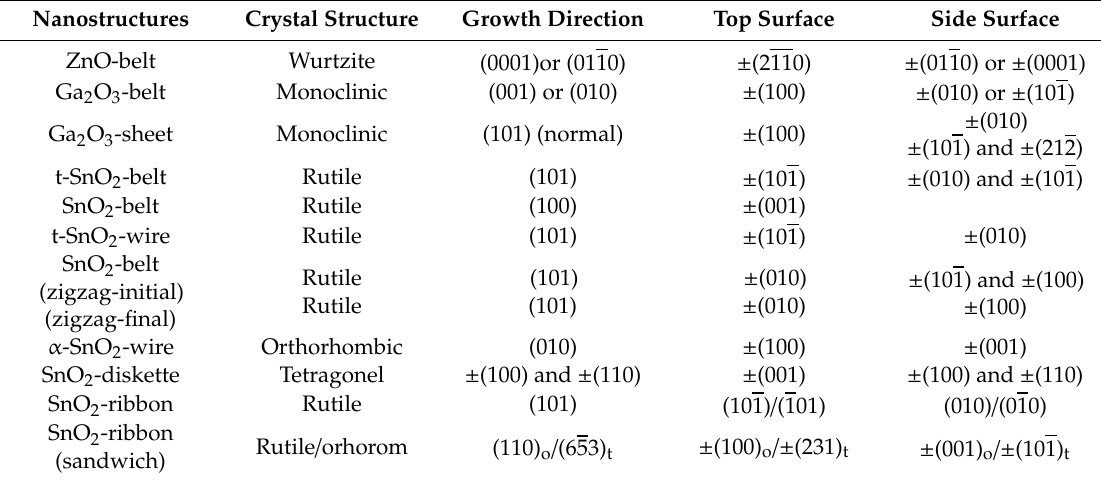
Table 2. Crystallographic geometry of one-dimensional oxide